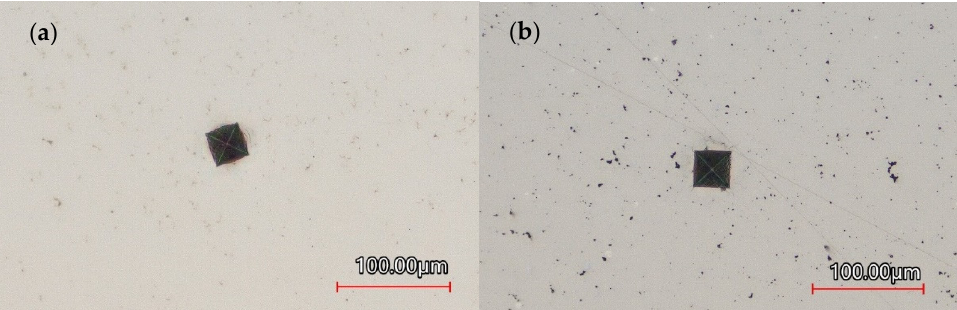
Figure 4. Vickers Indent on Coating Surface: ( a ) Monolithic Ni-P, ( b ) Ni-P-NiTi Composite Coating.